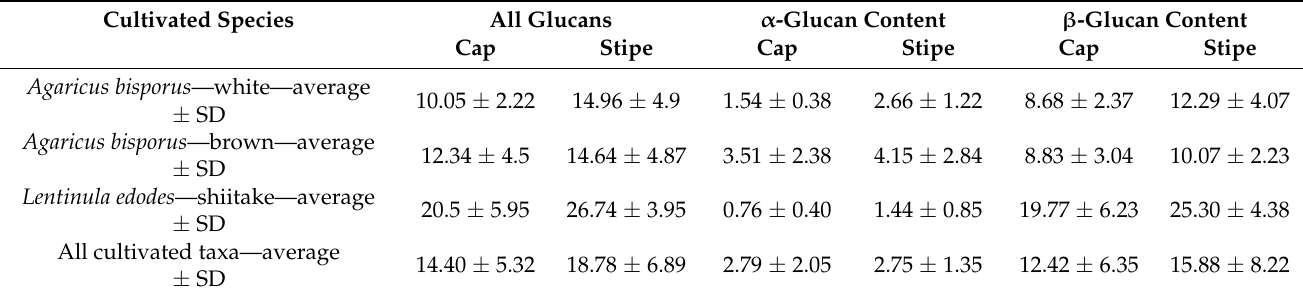
Table 6. Average glucan (all, α , and β ) contents in caps and stipes of three cultivated taxa (in % of DM) [32].